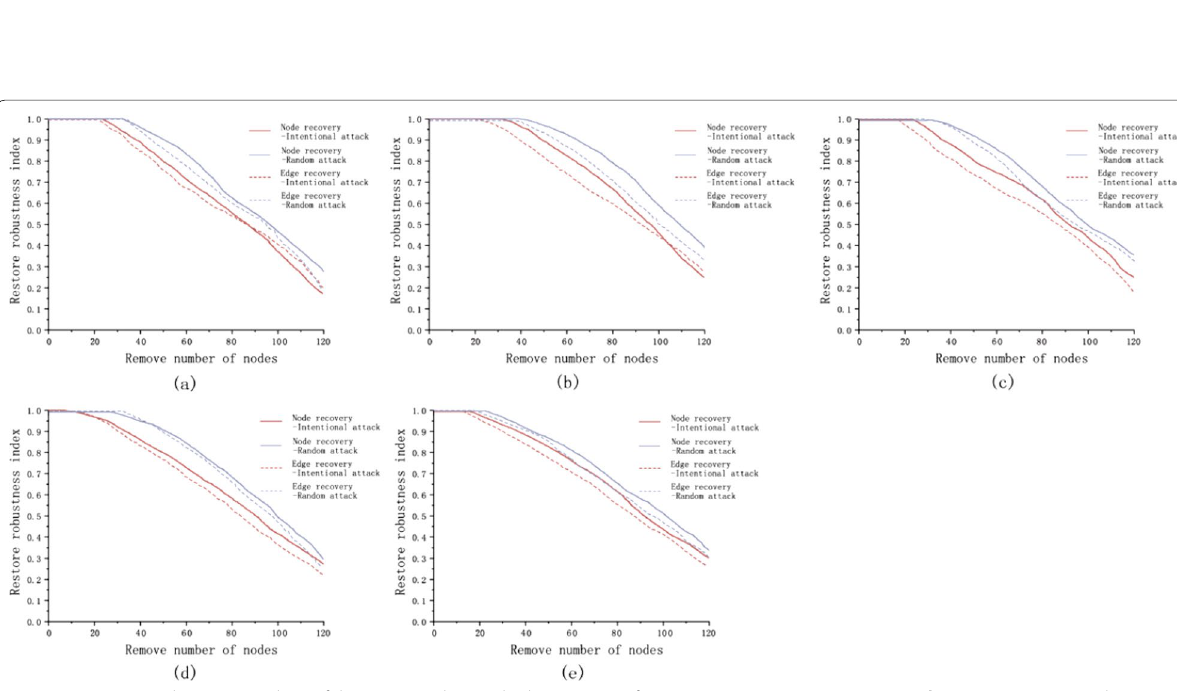
Fig. 10 Recovery robustness analysis of the GI network in multiple scenarios after optimization. a Current scenario, b 5% economic growth scenario, c 10% economic growth scenario, d 15% economic growth scenario, e 20% economic growth